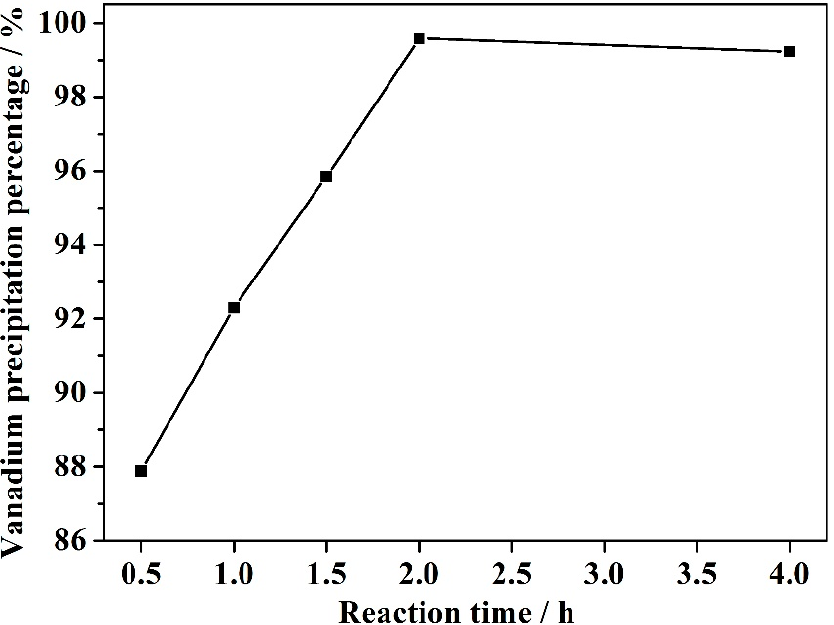
ff ect of reaction time on vanadium precipitation Figure 9. The effect of reaction time on vanadium precipitation percentage. Figure 9. The e